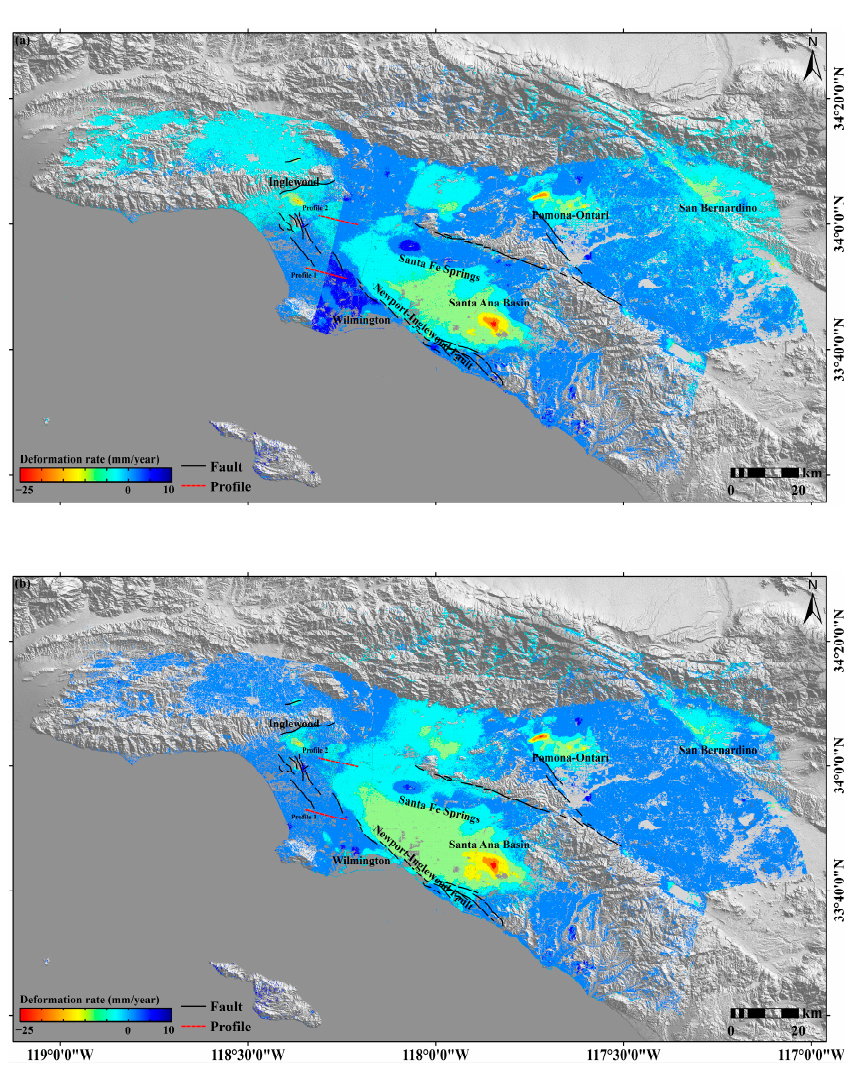
Figure 5. Annual deformation rate of Southern California. ( a ) is before correction; ( b ) is after correction. The background is SRTM DEM with a resolution of 30 m.